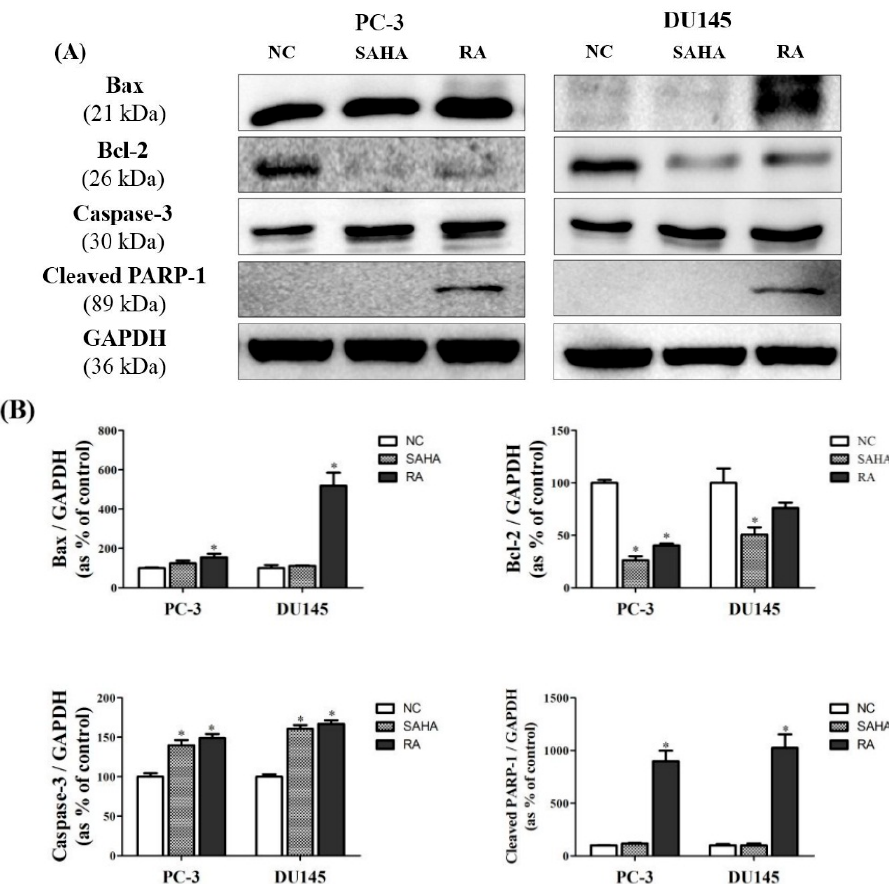
Figure 7. Effects of SAHA and RA on expression of apoptosis related genes in PC-3 and DU145 cell lines. After both cell lines were seeded at 1 × 10 6 in cell culture dishes and treated with media containing NC (DMSO), SAHA (1 µ M) and RA (200 µ M), the western blot analysis was performed. ( A ) The expressions of Bax, Bcl-2, caspase-3 and poly [ADP-ribose] polymerase 1 (PARP-1) (cleaved) at the protein level were confirmed by western blot analysis. ( B ) The expression levels of each gene were quantified and normalized to GAPDH. The results are expressed as means ± SD. * p < 0.05: a significant difference versus control.